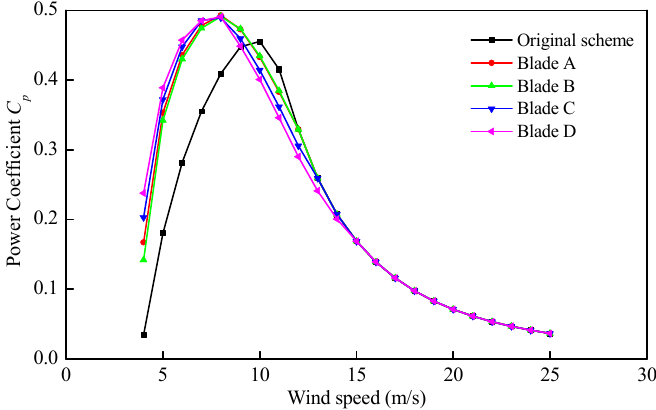
Figure 17. Comparison of power coefficient under different wind speed.